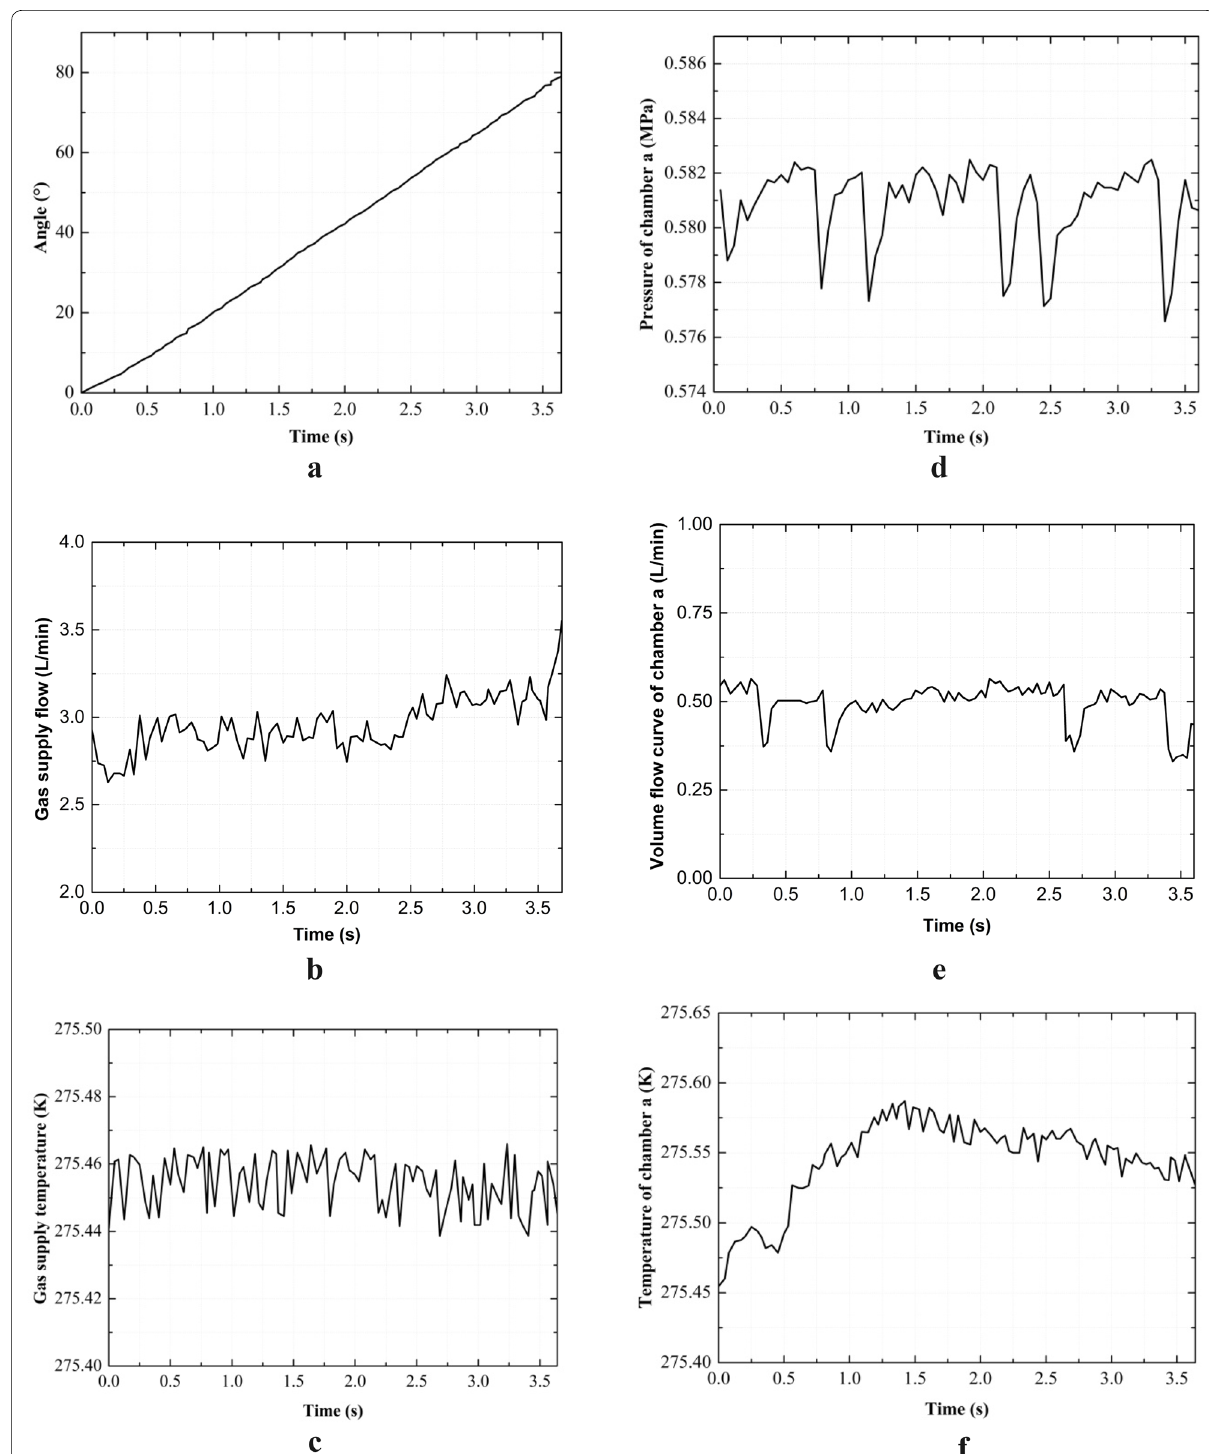
Figure 9 System-response curve at gas supply pressure of 0.6 MPa: ( a ) Angle curve, ( b ) Gas supply flow, ( c ) Gas supply temperature, ( d ) Pressure curve of Chamber a , ( e ) Volume-flow curve of Chamber a , ( f ) Temperature curve of Chamber